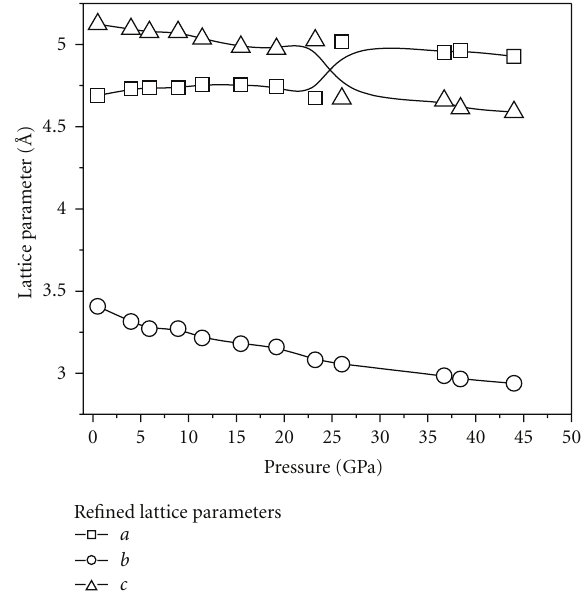
Figure 7: Variation of lattice parameters with pressure of 2% Fe- doped bulk CuO sample. The error in the lattice parameters is equivalent to the size of the markers.